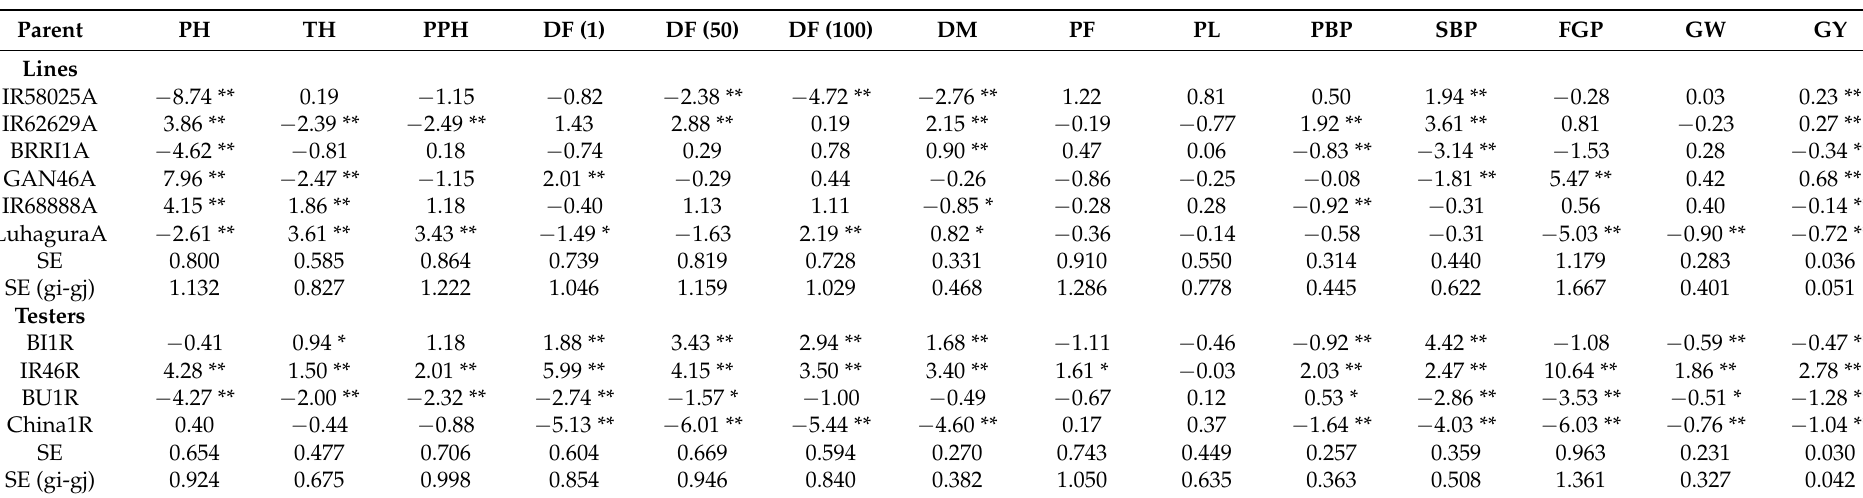
Table 3. General combining ability (GCA) effects of parents (lines and testers) for yield and its contributing